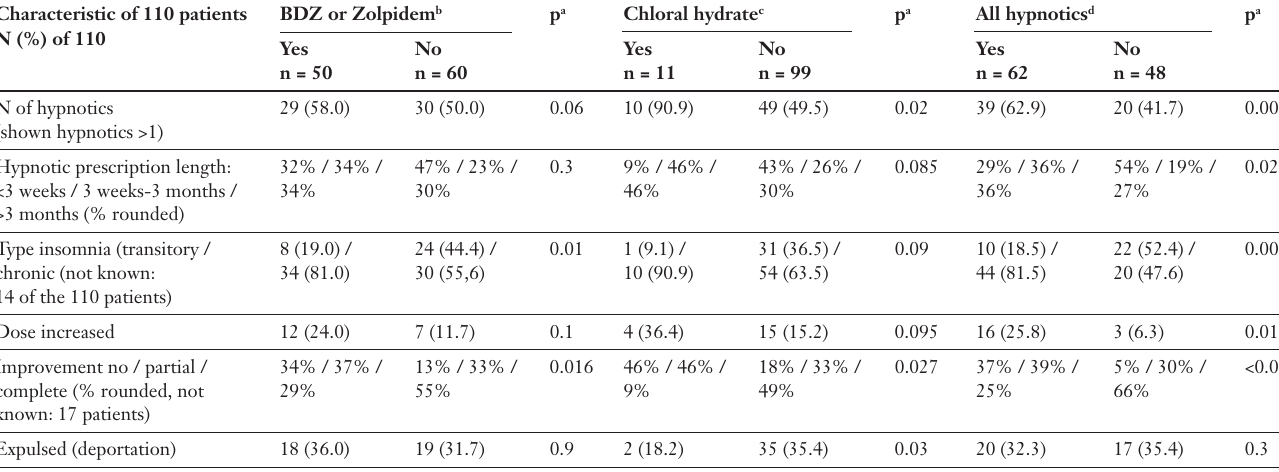
Comparison of characteristics of prisoner patients leaving prison with hypnotics still prescribed vs. prisoner patients without such prescriptions among the 110 non-substance-misusing insomnia patients (shown only if significant differences between patients with versus without hypnotics when leaving